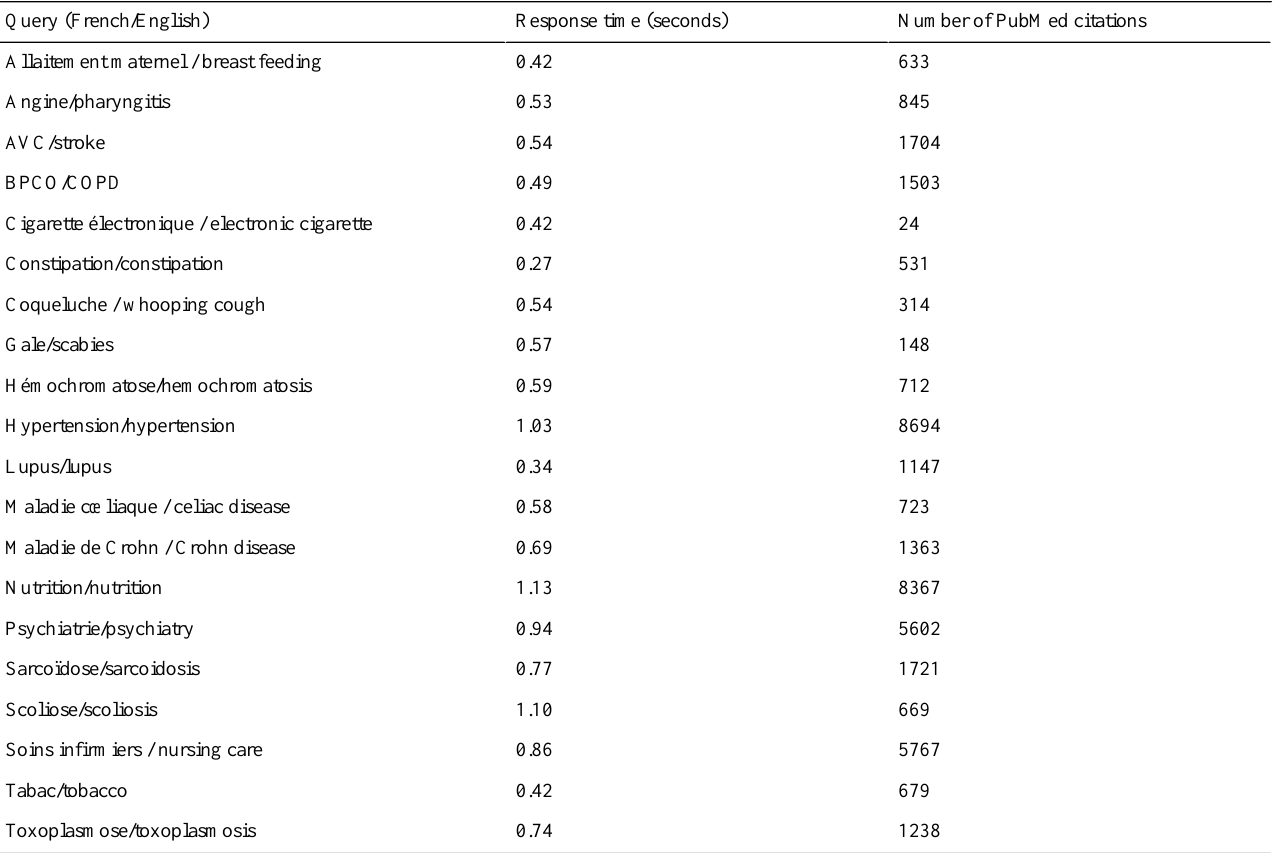
Table 3. Response times for the 20 Multilingual PubMed-French